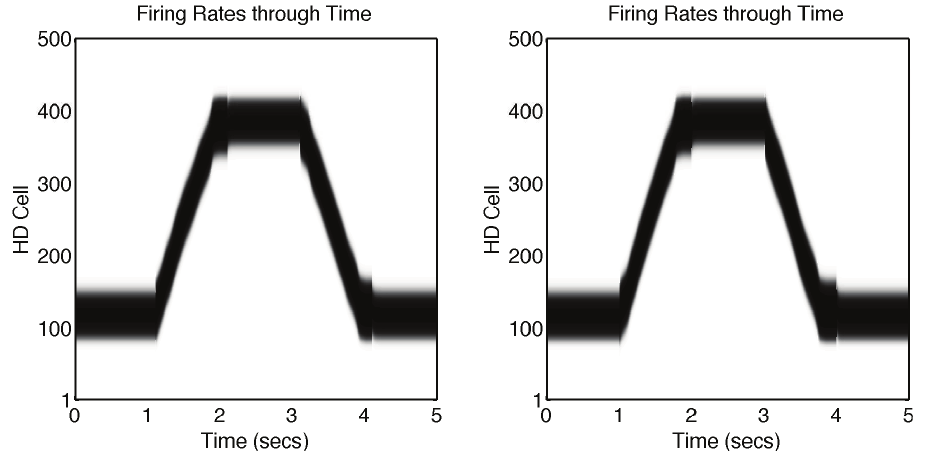
Figure 11. Firing rates of the head direction cells from models with axonal conduction delays in one set of the w 2 or w 3 synapses only . The left-hand plot displays the head direction cell firing rates recorded during the testing, in the absence of visual input, of a model simulated with axonal conduction delays in the w 2 synapses only. It is clear that the model can still learn to perform path integration of head direction. The right-hand plot displays the firing rates of head direction cells recorded during the testing, in the absence of visual input, of a model simulated with axonal conduction delays in the w 3 synapses only. It is also clear that the model can still learn to perform path integration of head direction.